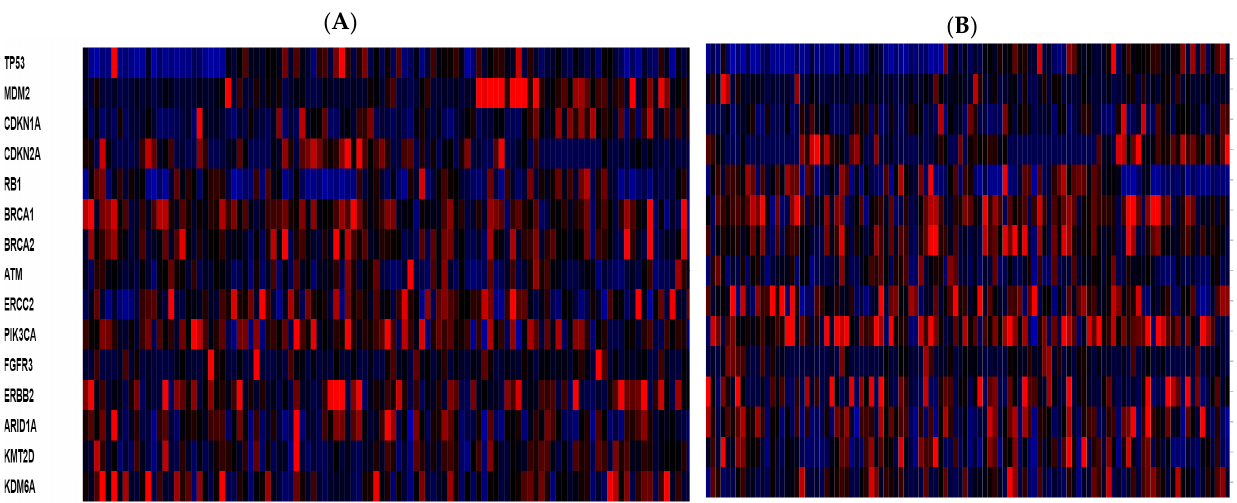
Figure 8. mRNA expression compared to diploid samples (RNA seq V2 RSEM) of key genes in bladder cancer pathogenesis in ( A ) cases with high TMB, and ( B ) representative cases with low TMB. Red denotes over-expression and blue under-expression.